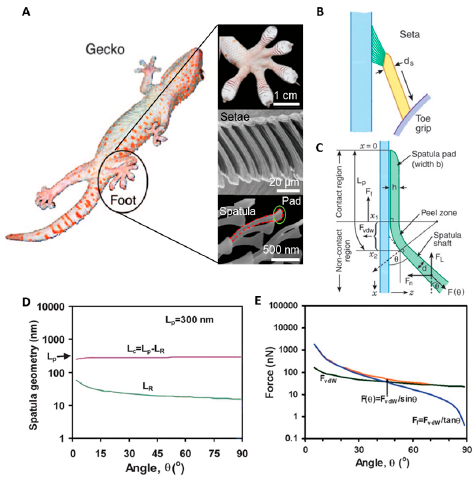
Figure 1. Gecko foot structure and its analysis. ( A ) The hierarchical structures of a gecko’s foot, which consist of setae, spatulae, and pads. (Foot image reproduced from [11], with permission from Annual Reviews); ( B , C ) Schematic diagram of the setae and parameters related to adhesion; ( D , E ) van der Waals force adhesion of the setae calculated using different contact angles with the substrate. (Figure reproduced from [10], with permission from the National Academy of Science, Washington, DC, USA.)